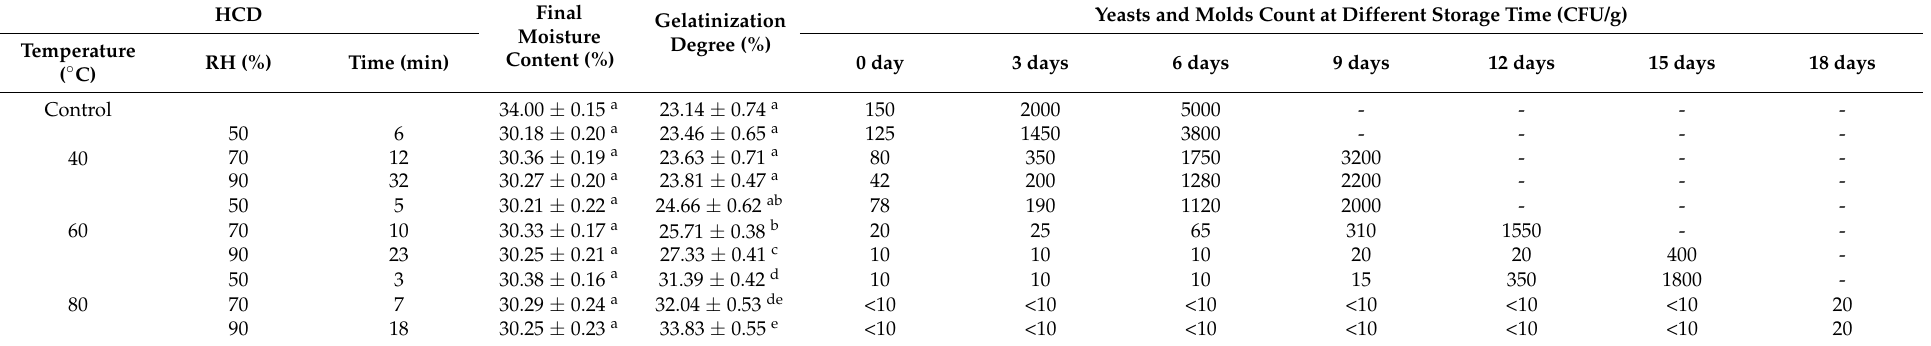
Yeasts and Molds Count at Different Storage Time (CFU/g)